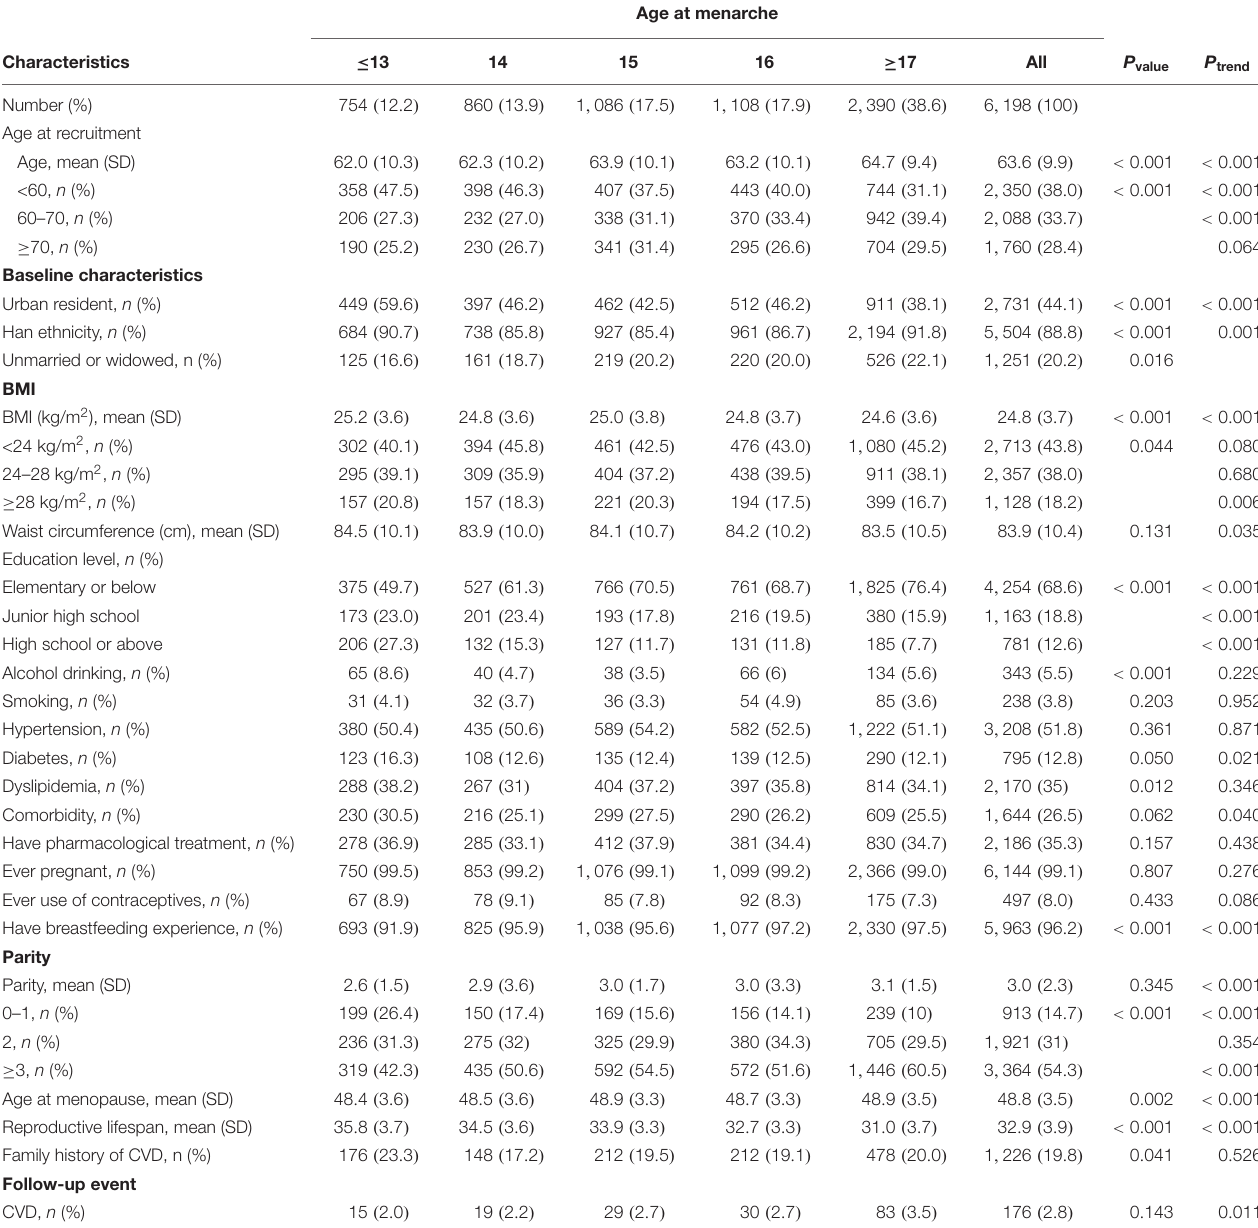
TABLE 1 | Characteristics of study participants by age at